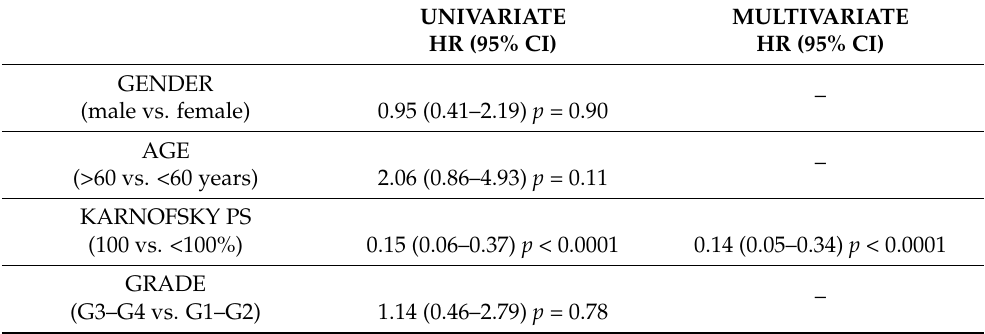
Figure 1. SSIGN score distribution in the two groups (RFS > 5 years (green) and RFS < 1 year (red)). X = SSIGN; Y = n pts. As expected, those patients who reported a RFS from the time of surgery of >5 years and a FGS had a longer OS than patients who reported a RFS of < 1 years and UGS. The univariate analysis on OS according to Cox regression model showed an association between Karnofsky Performance Status ( p < 0.0001), tumor stage ( p = 0.03), and SSIGN score ( p = 0.003) and signature ( p < 0.0001); no association was found for gender ( p = 0.90), age ( p = 0.11), grade ( p = 0.78), necrosis ( p = 0.75), and type of surgery ( p = 0.08). (Table 3) However, at the multivariate analysis, when significant associations were tested simultaneously, and not considering signature, only Karnofsky ( p < 0.0001) and SSIGN ( p = 0.006) maintained their significance. When introducing signature, this was the only significant parameter (HR 51.34 (6.75–390.96); p < 0.0001)) (Table 3). Table 3. Cox proportional hazard model with overall survival as